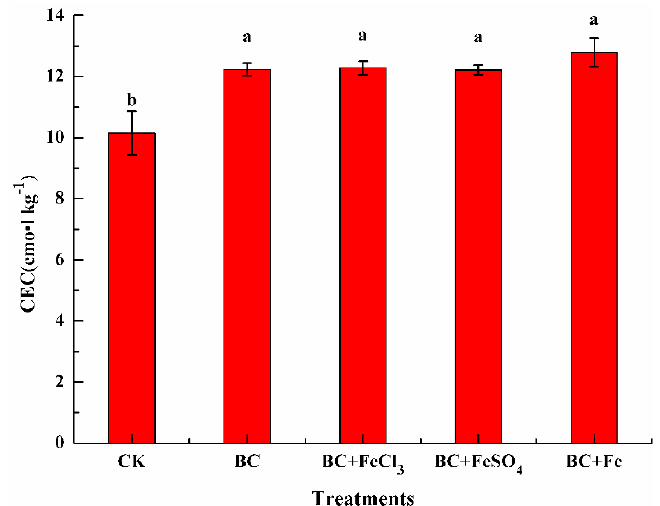
Figure 4. The effect of different treatments on soil cation exchange capacity (CEC). Note: different letters for the Figure 4 indicates that the differences are statistically significant ( P < 0.05).